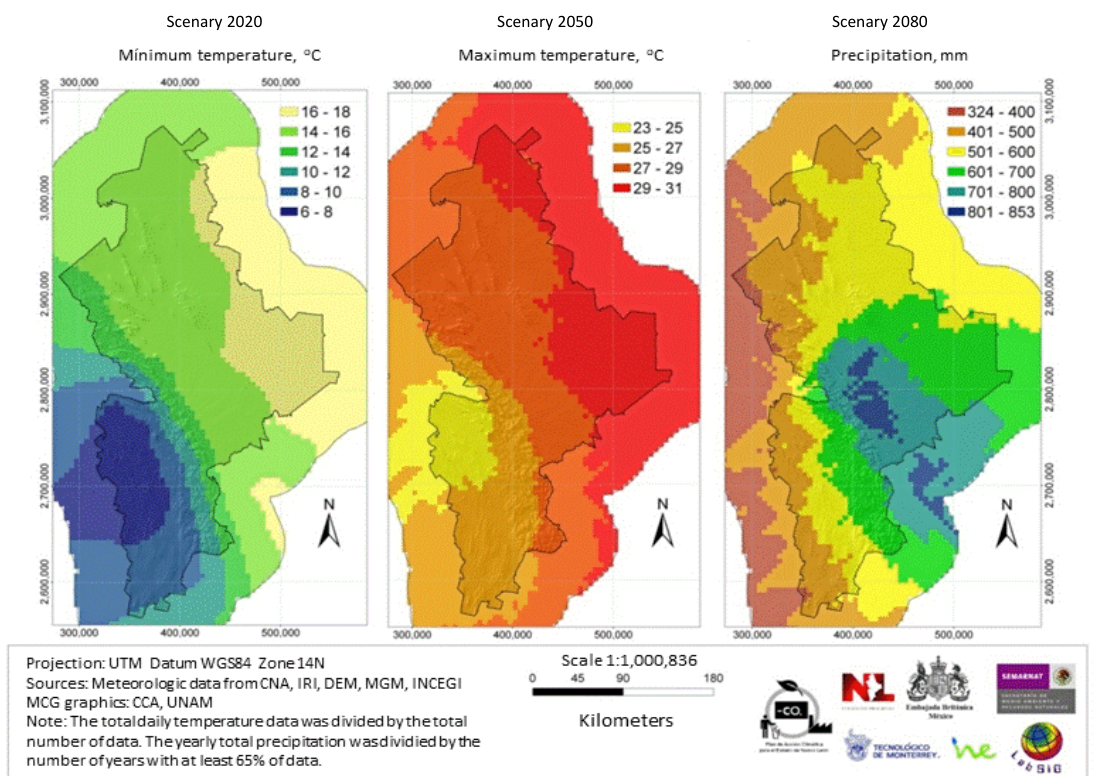
Figure 3. Mean precipitation and minimum and maximum temperature from 1960 – 1990.